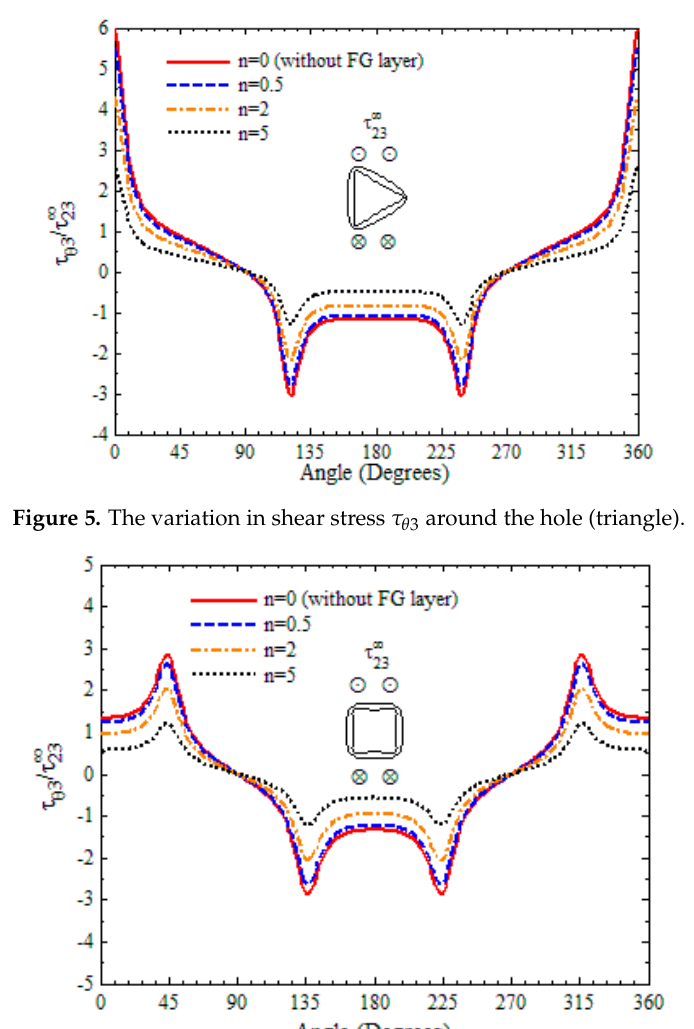
τ around the hole (square). 3 θ